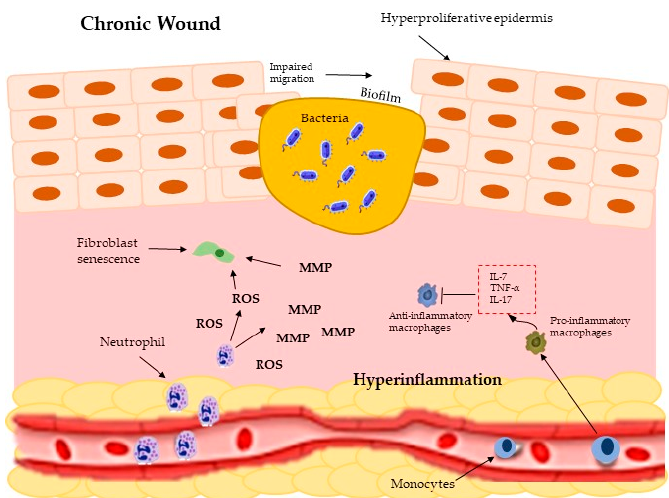
Figure 2. Chronic wound exhibit and persistent inflammation, an infection (biofilm), hyperproliferative epidermis, fibroblast senescence, elevated MMPs (metalloproteinases), impaired migration.